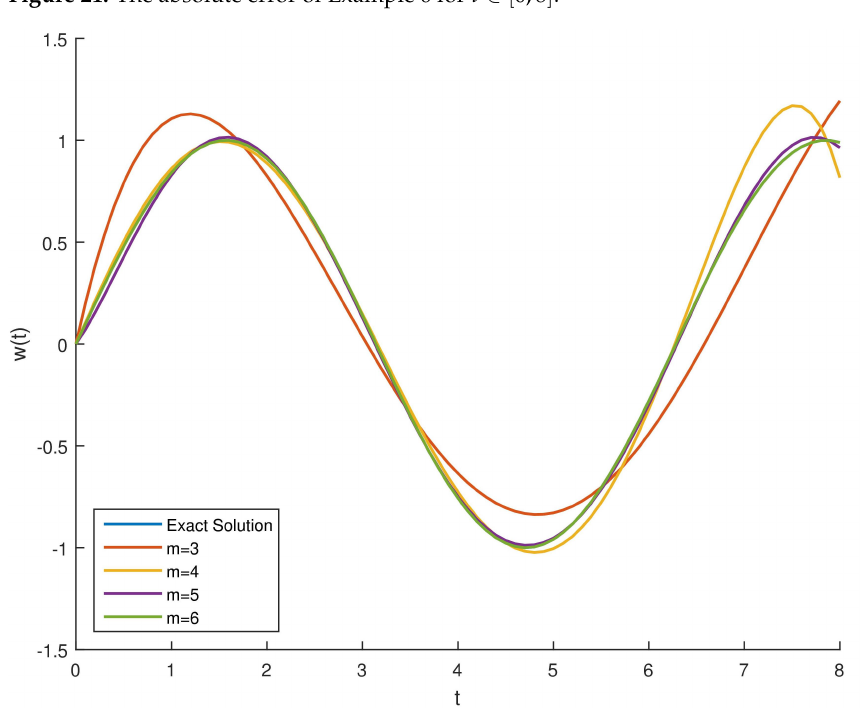
Figure 22. The demonstration of the exact and approximate solutions for Example 6 with different m values where t ∈ [ 0,8 ]